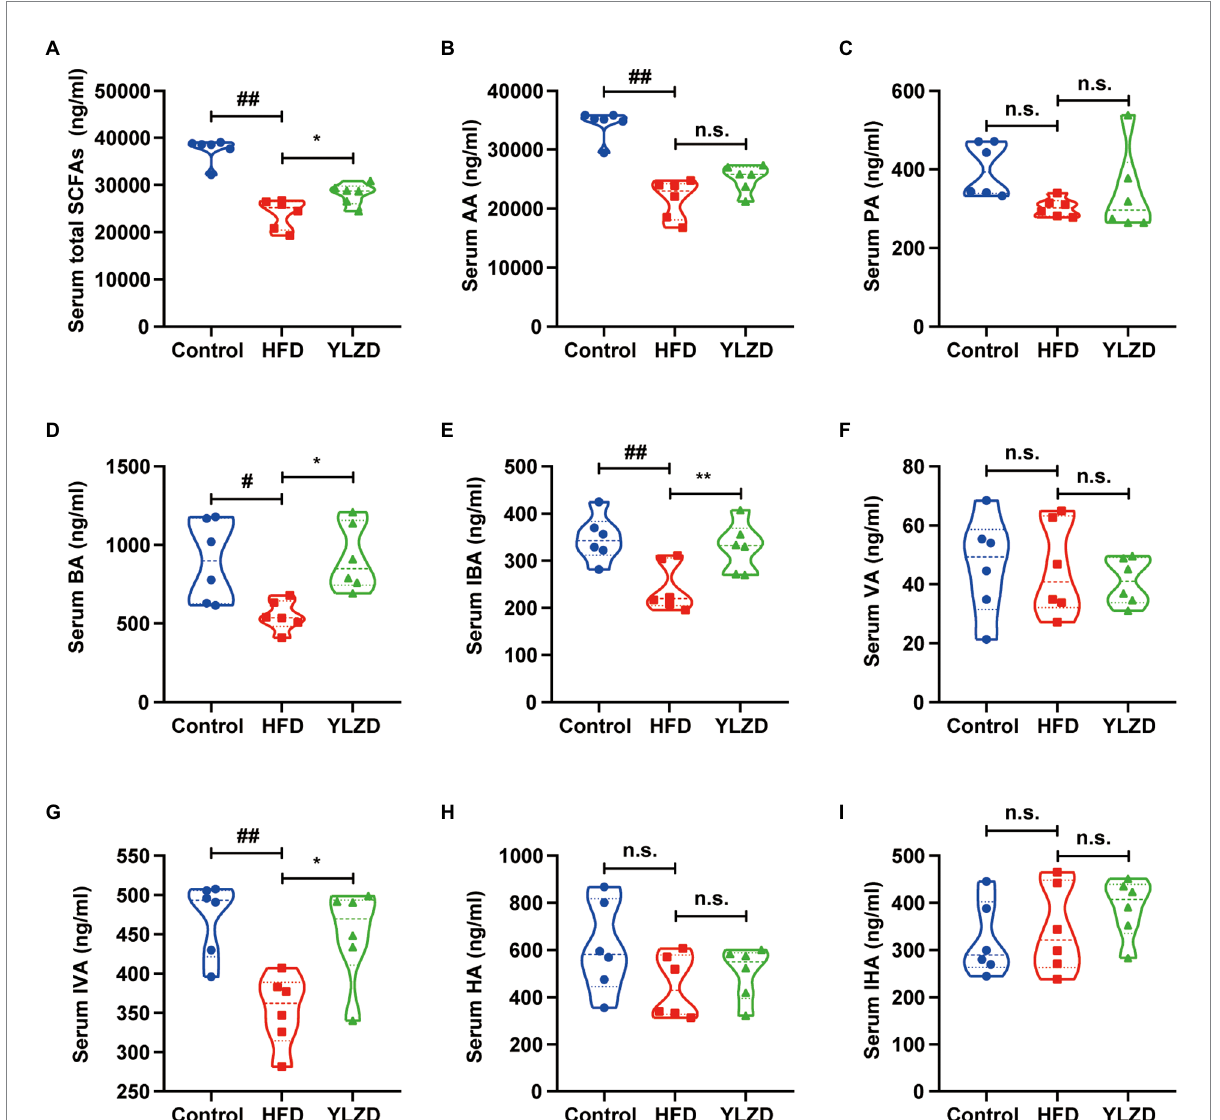
FIGURE 4 YLZD increased the concentration of serum SCFAs. (A) Serum total SCFAs, (B) serum AA, (C) serum PA, (D) serum BA, (E) serum IBA, (F) serum VA, (G) serum IVA, (H) serum HA, (I) serum IHA. AA, PA, BA, IBA, VA, IVA, HA and IHA are acetic acid, propionic acid, butyric acid, isobutyric acid, valeric acid, isovaleric acid, hexanoic acid and isohexanoic acid, respectively. Values are represented as mean ± SEM ( n = 6 rats/group). ## p < 0.01, # p < 0.05 versus the Control group; ** p < 0.01, * p < 0.05 versus the HFD